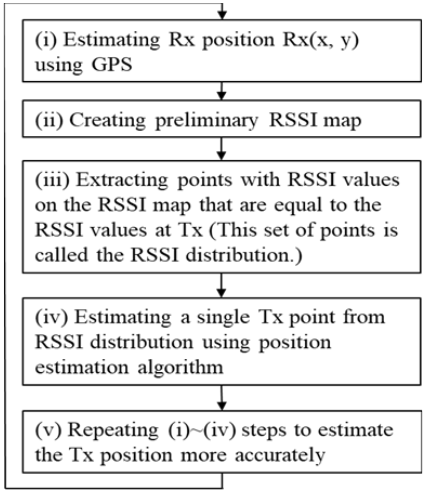
Figure 2. Flowchart of the proposed